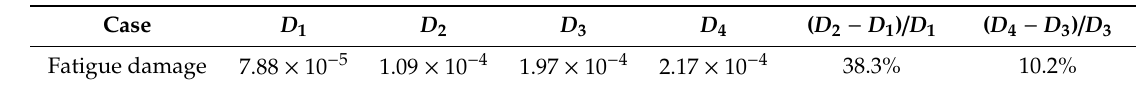
Table 3. Comparison of fatigue